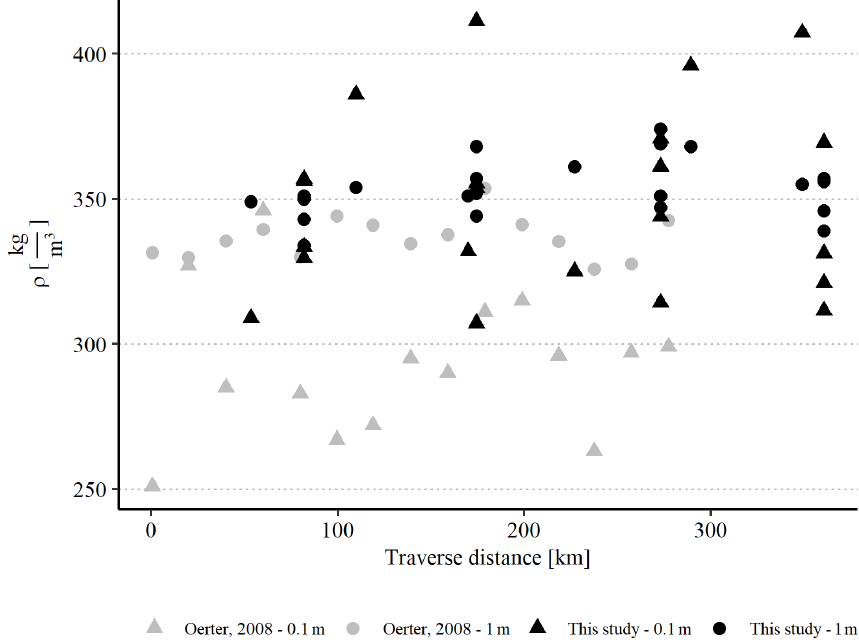
Figure 10. Density values of this study (black) in comparison with those from snow pit sampling by Oerter (2008) (grey). The samples are taken along a comparable transect line. Density is given as mean value from the snow surface to the respective depth. The spatial variability in both 1 and 0.1m intervals can be seen by the spread of points in data of this study at one sampling location (comp. Table